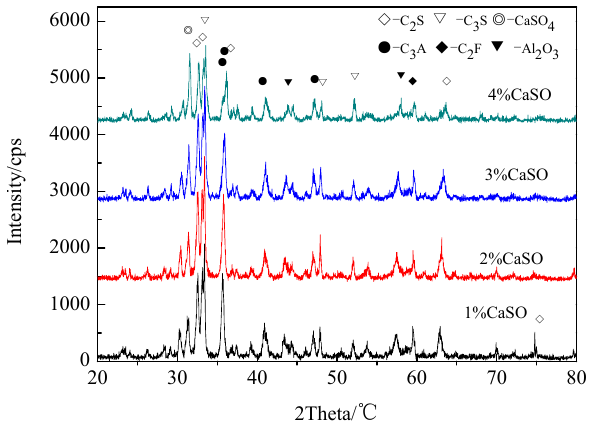
Figure 7: XRD patterns of reconstructed steel slag with different CaSO 4